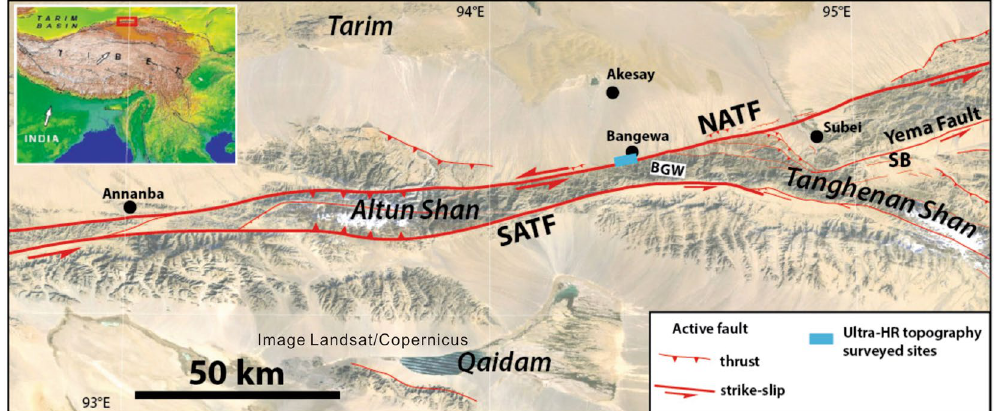
Figure 1. Overview of the northeast section of the Altyn Tagh fault (see red rectangle in the inset for location). NATF: North Altyn-Tagh fault, SATF: South Altyn-Tagh fault. The study site is located on the NATF, at the Bangewa site (BGW). Active faults were mapped onto a background image from Google (Image Landsat/ Copernicus) based on the Adobe Illustrator mapublisher (http://www.avenza.com/mapublisher). The inset map background is based on a global digital elevation model (GTOPO30 DEM with a horizontal grid spacing of 30 arc seconds, courtesy of the U. S. Geological Survey).